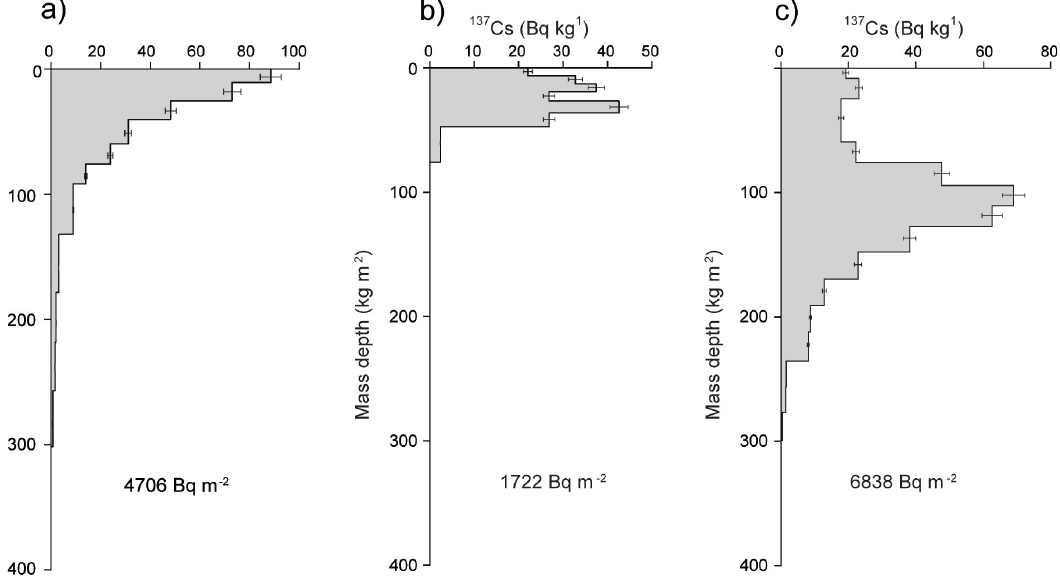
Fig. 3 The 137 Cs depth distributions for the reference site (a), an eroding site (b), and a depositional site (c) within the Melito catchment. The error bars depict the 95% confidence limits of the measured radionuclide